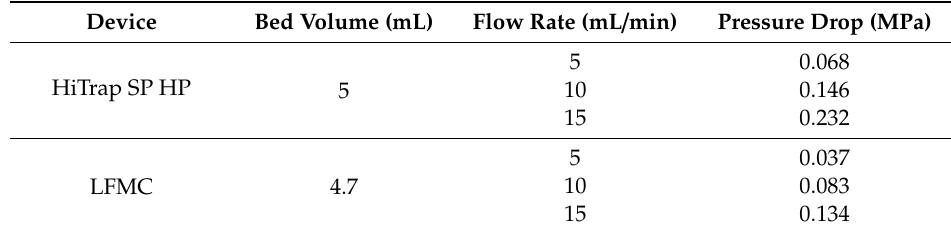
Table 3. Pressure drop in HiTrap SP HP column and LFMC device during the separation of model protein mixture at different flow rates.